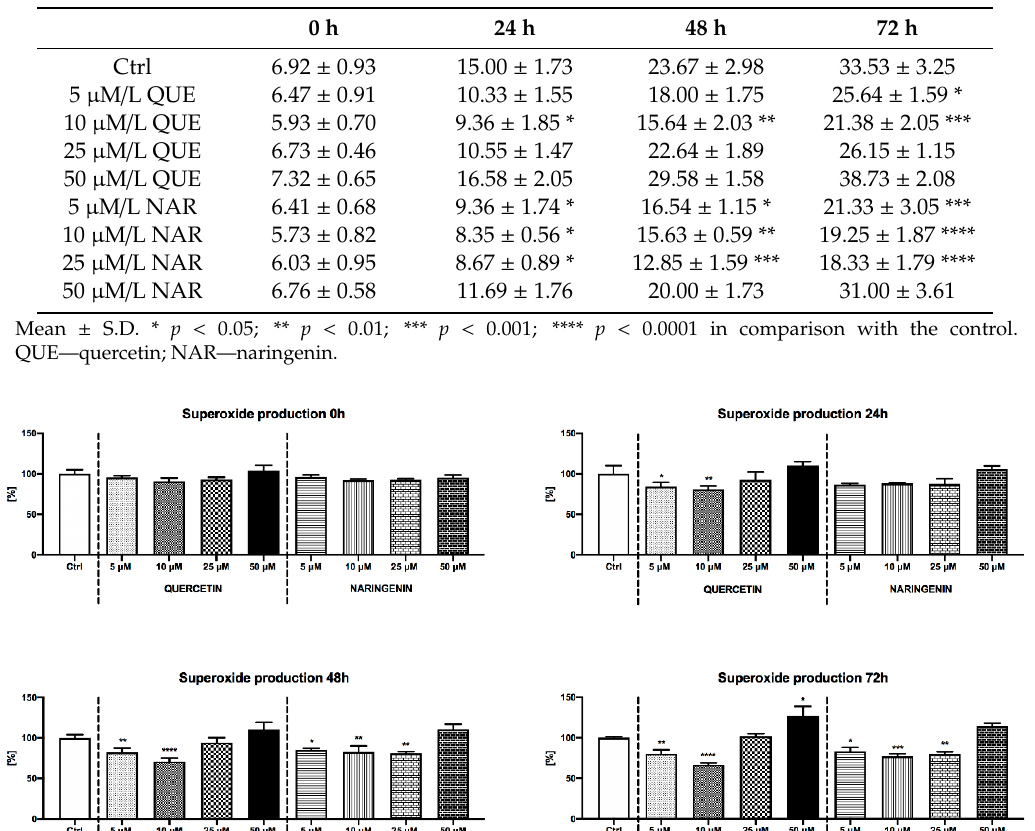
Table 5. The effect of quercetin and naringenin on the reactive oxygen species (ROS) production (RLU/s/10 6 sperm) by extended boar spermatozoa ( n = 28).